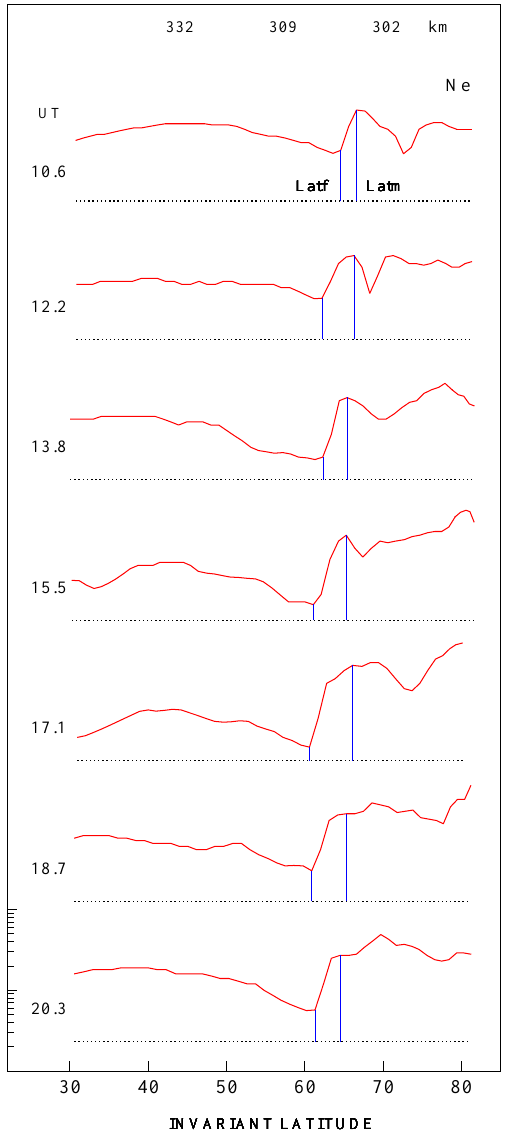
Fig. 1. Examples of well-defined polar cliff structures. A sequence of seven latitudinal profiles of the electron density is shown. It was obtained by the Dynamics Explorer 2 satellite on 22 Decem- ber 1981. The respective universal time of observation is indicated to the left of each profile. The density is plotted on a logarithmic scale, an example of which is shown in the bottom part of the fig- ure. For each profile, a dotted line marks the 2 . 3 × 10 10 m − 3 density level. The data refer to the Northern Hemisphere winter. Solar local time of observation was approximately 04:40, and the magnetic lo- cal time varied between about 3 and 5h. Typical observation heights are indicated at the top of the figure. The geomagnetic activity was relatively weak, with the AE6 index varying between 71 and 128nT. For each profile, vertical blue lines mark the foot of the polar cliff (latf), and the first maximum/plateau